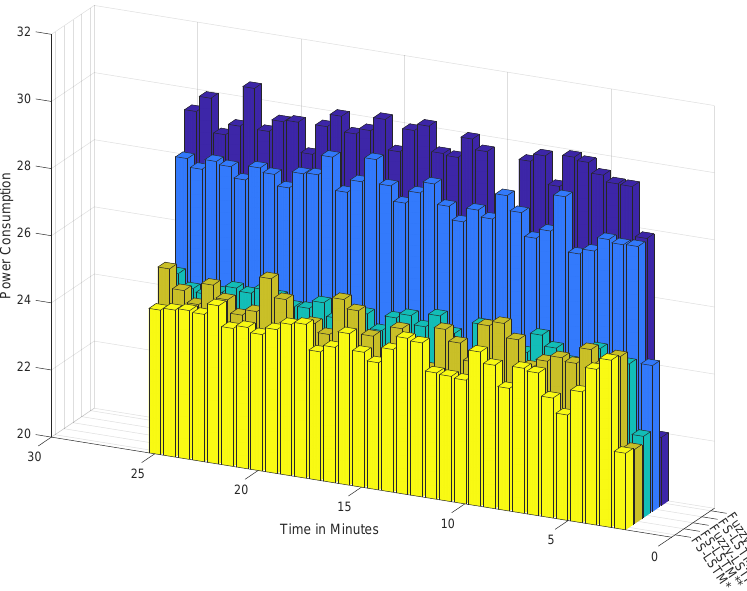
Figure 13. The benchmark of power consumption during testing. Fuzzy-LSTM and FS-LSTM networks trained with 32 layers (denoted with *), and a hybrid version of FS-LSTM (denoted with